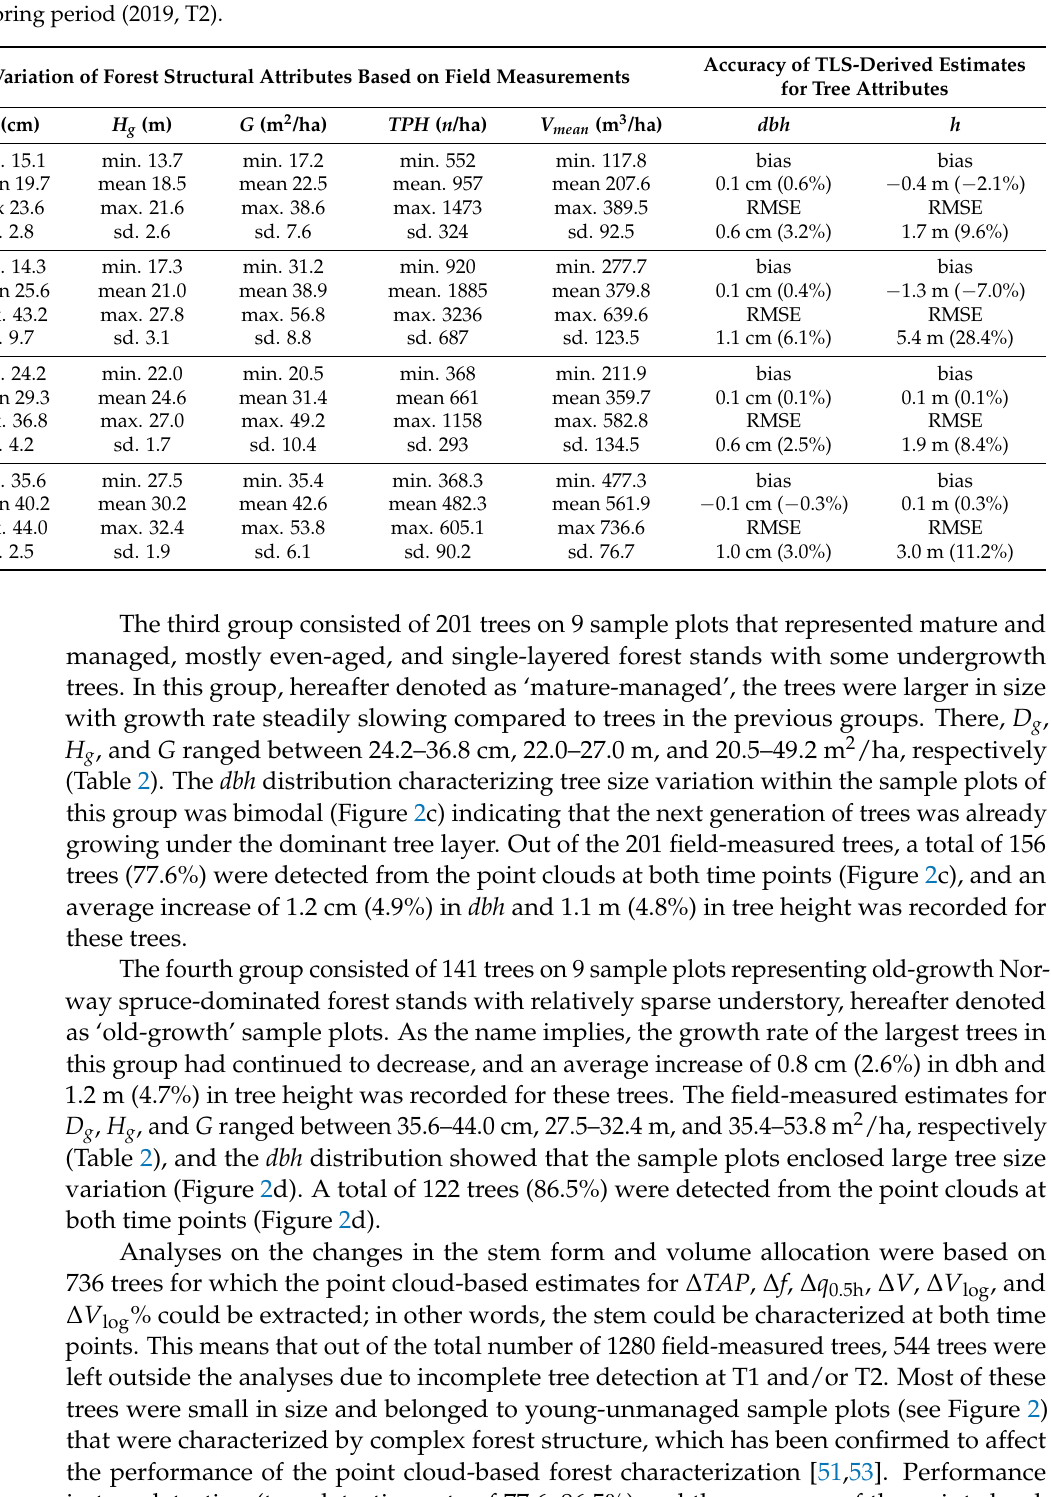
Table 2. Variation of field-measured forest structural attributes such as basal area-weighted mean diameter ( D g ) and -height ( H g ), mean basal area ( G ), the number of trees per hectare ( TPH ), and mean volume ( V mean ) which were aggregated from the tree attributes at the sample plot level, as well as the bias and root mean square error (RMSE) of terrestrial laser scanning (TLS) point cloud-derived estimates for diameter at breast height ( dbh ) and tree height ( h ) for each forest structural group at the end of the monitoring period (2019,